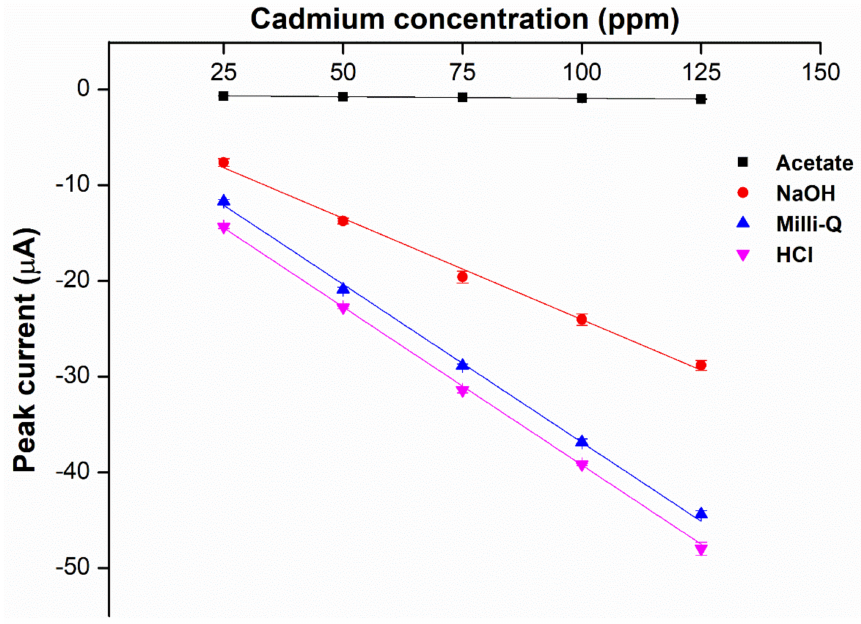
Figure 6. Effect of supporting electrolytes (SE) on the sensitivity of the hybrid plasticizer sensor ( n =